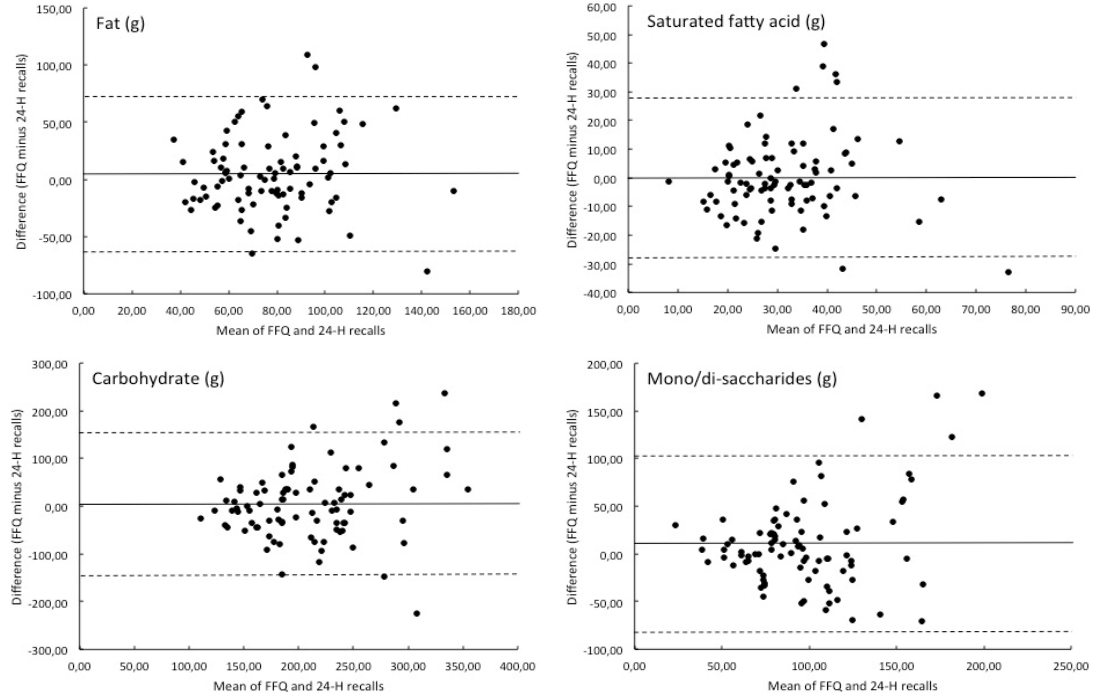
Figure 1. Bland–Altman plots of intake of energy, total protein, total fat, saturated fatty acids, total carbohydrates, and mono / di-saccharides assessed by the HEalthy LIfe in an Urban Setting (HELIUS) FFQ versus the mean of three 24-hour dietary recalls (24-H recalls) for 88 validation study participants of the Longitudinal Aging Study Amsterdam.